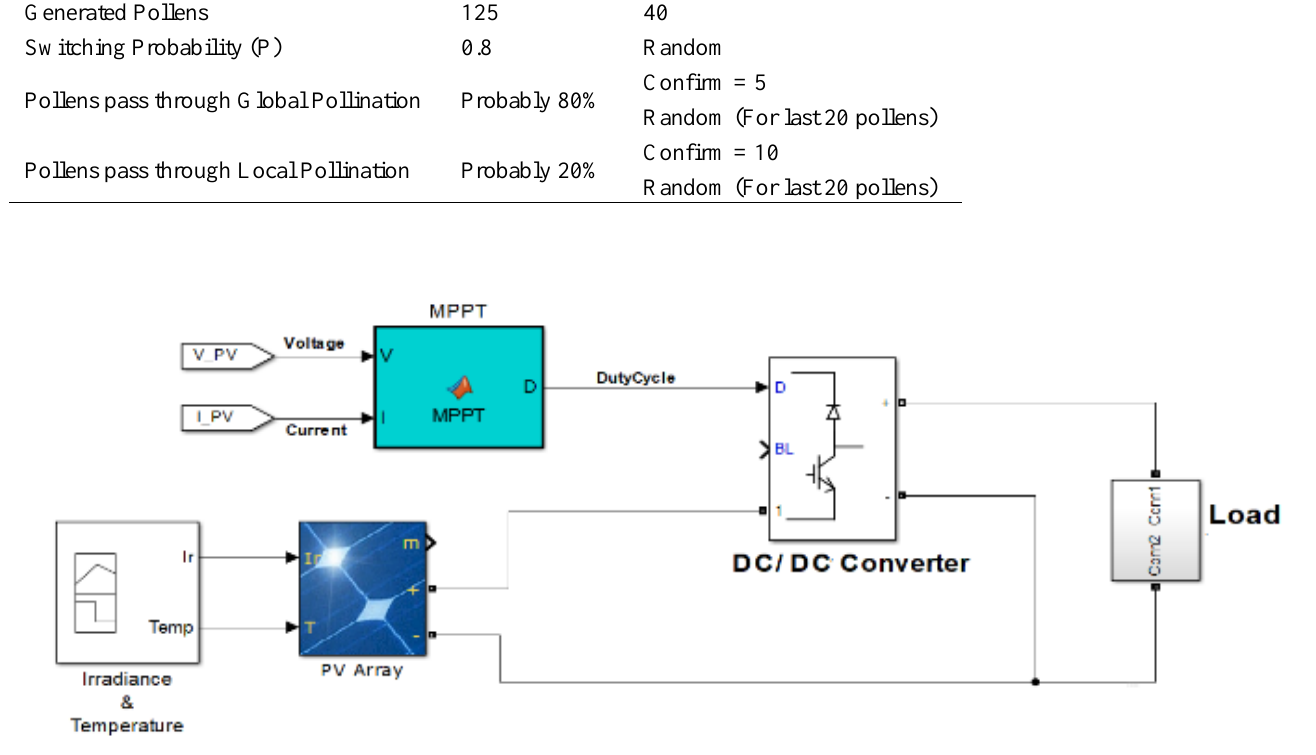
Fig. 5. Off-grid solar photovoltaic system.